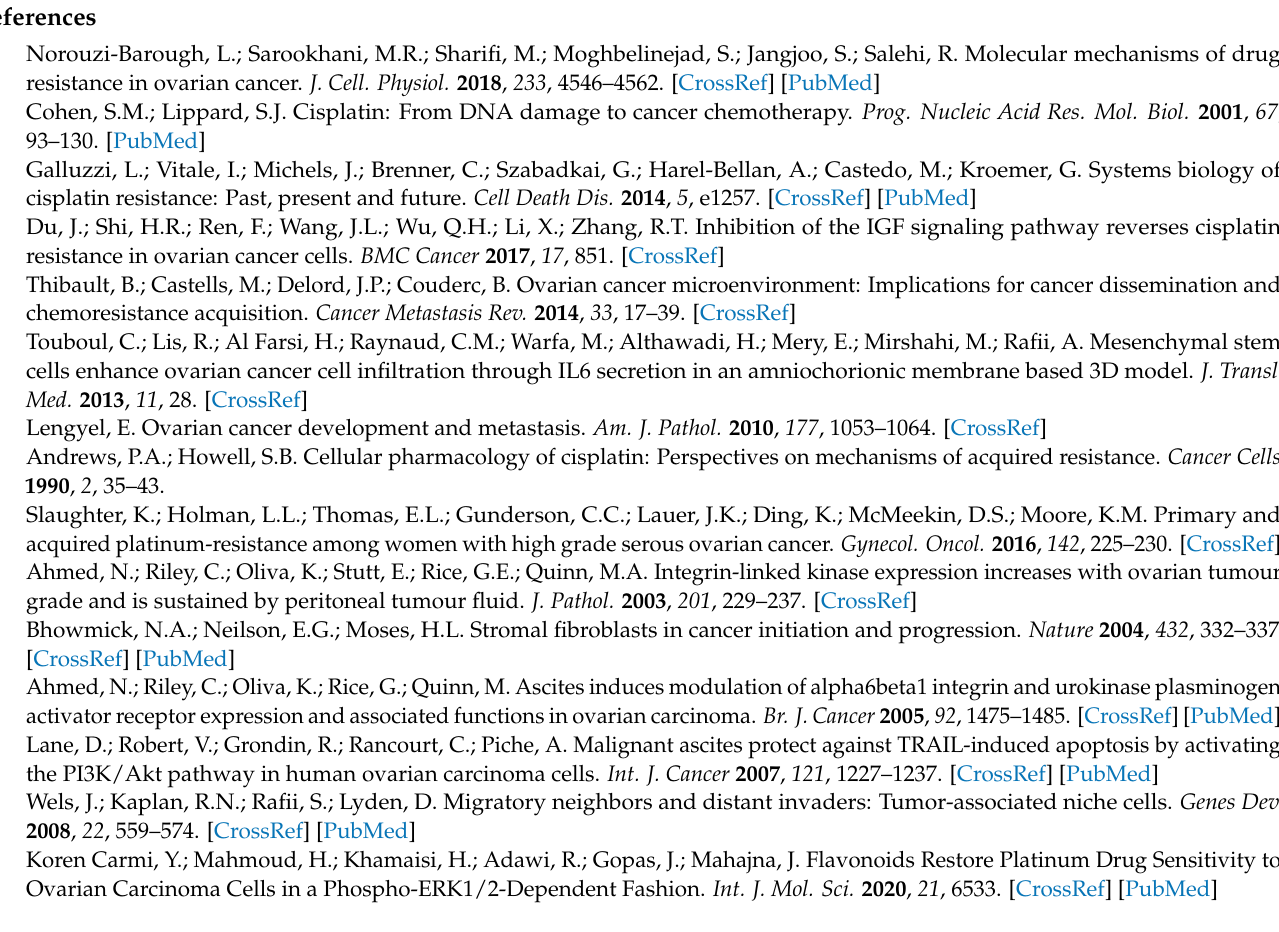
Figure S1: cPARP levels in A2780CisR and MS-5 in RJY13 treated cells, and Figure S2: Effect of